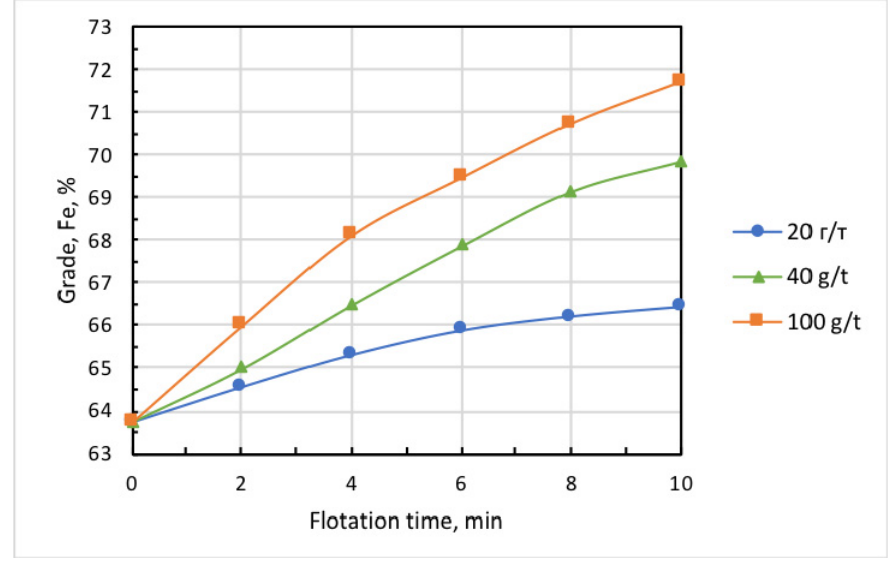
Figure 7. Kinetics of concentrate-grade increment at varied doses of Lilaflot 821M collector. Air flow rate, 0.3 L/min. Table 1. Flotation of Magnetite/Ballotini mixture without microbubbles. Flotation time, 10 min. Airflow rate, 0.3 L/min.